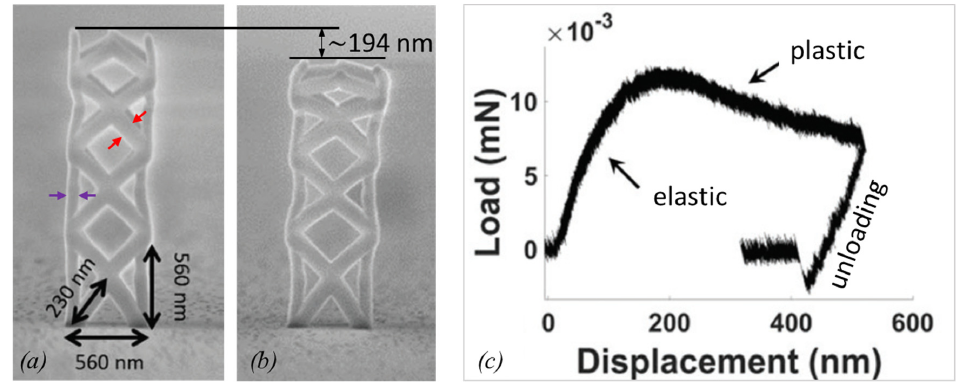
Figure 24. Compression along the vertical axis of a 3D FEBID tower truss lattice structure. ( a ) Initial lattice dimensions. Note the different dimension of the zigzag units in front view (red arrows) and projected view (purple arrows). ( b ) Dimensions after 500 nm compression along the long lattice axis.